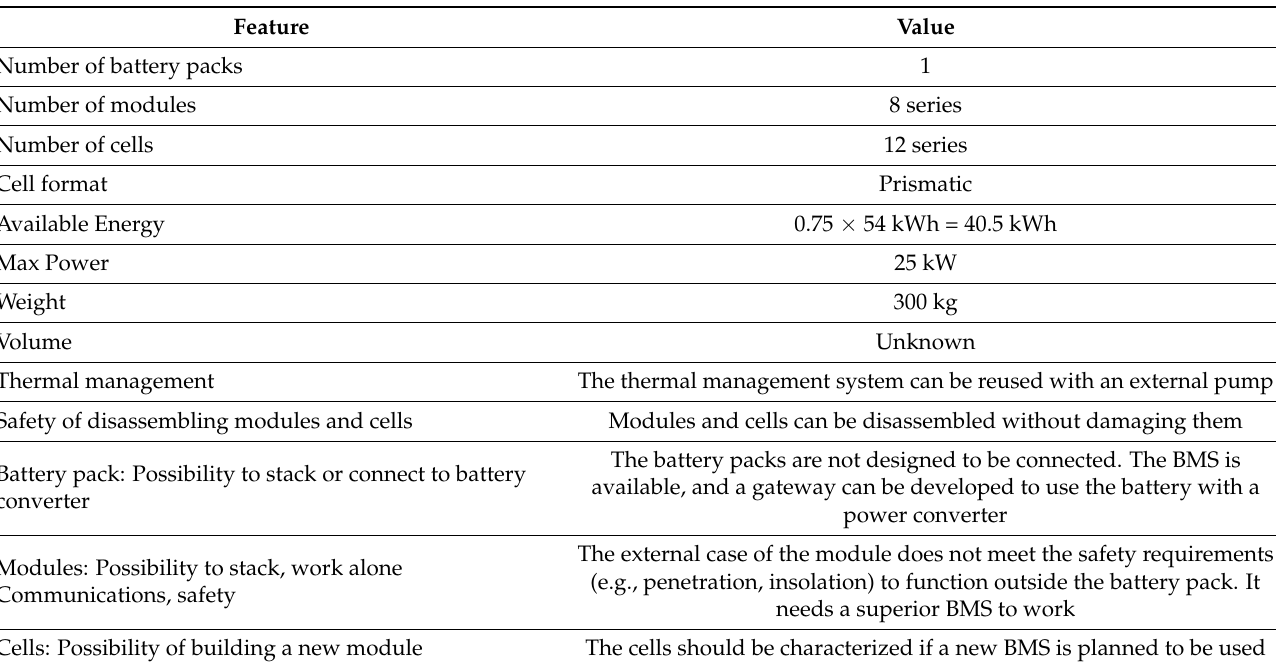
Table 6. Information available for the technical feasibility part of the case